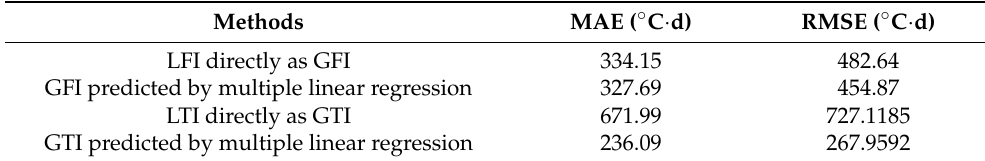
Table 5. Errors of multiple linear regression